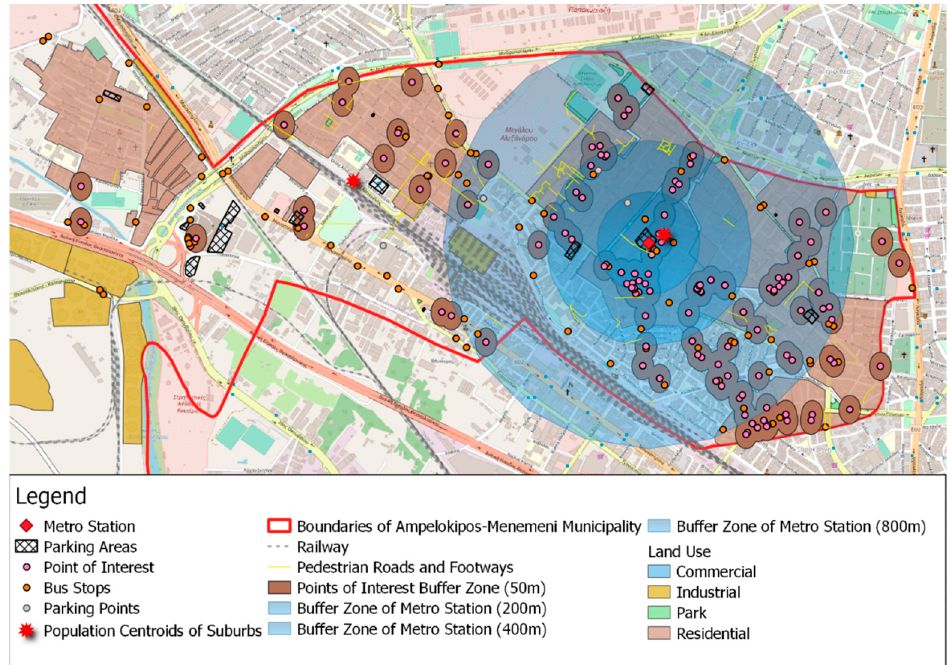
Figure 6. Points of Interest in the area (Background map: © OpenStreetMap contributors [88]).